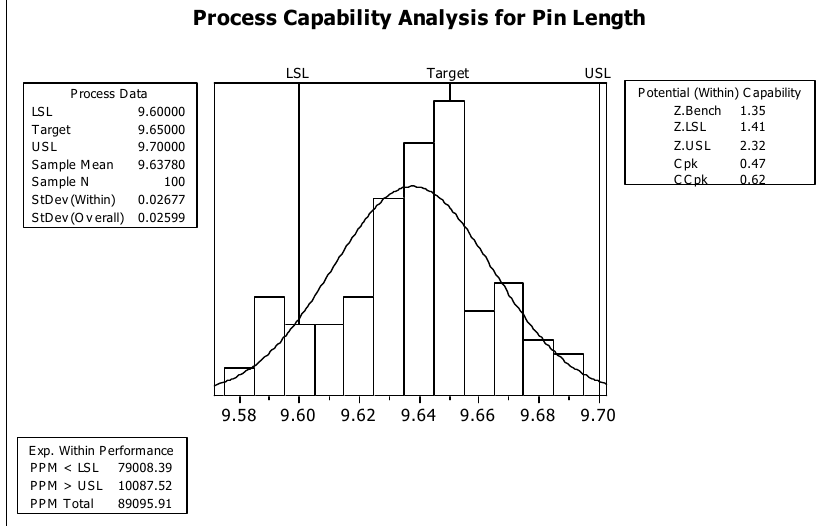
Fig. 4. C pk Analysis of Pin Rejection before Implementing DMAIC Methodology